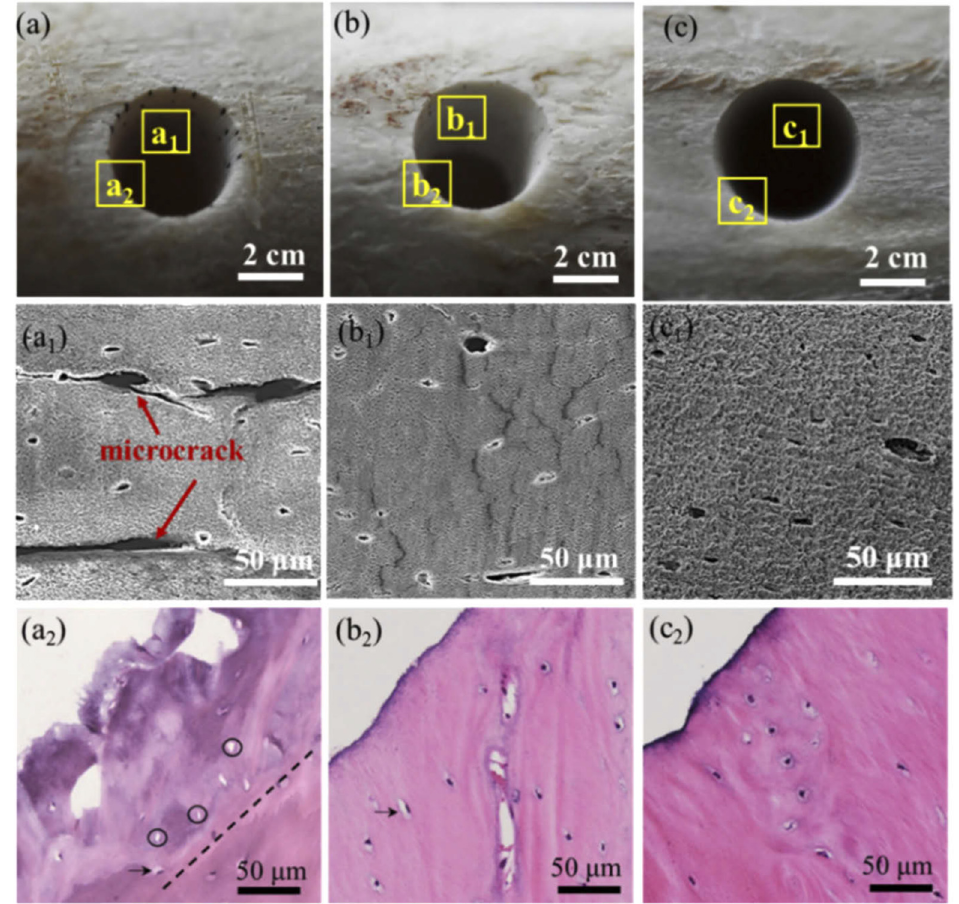
Figure 2. Morphology of laser-drilled bone tissues under different environmental cooling conditions. Vertical panels ( a – c ) correspond to without cooling, gas cooling and water cooling; horizontal panels (subscript: none, 1, 2) correspond to white light, SEM and histology images. Adapted from [42].